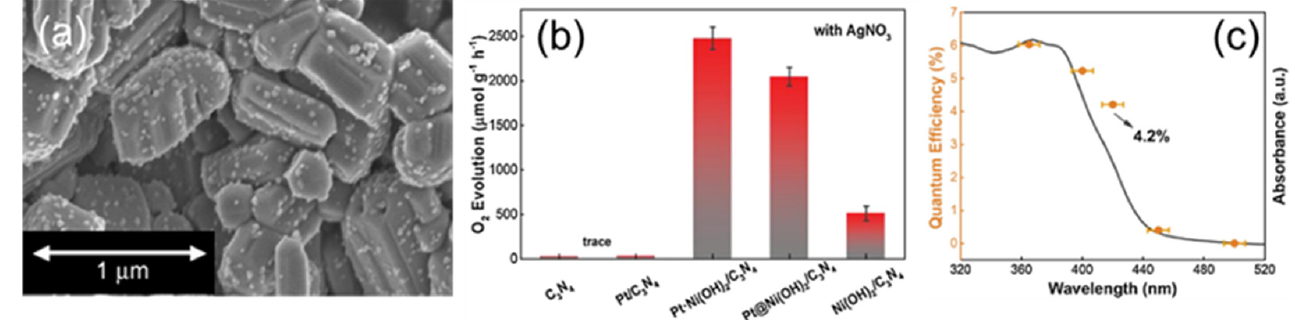
Figure 5. ( a ) SEM image of RuO 2 -loaded β -Ge 3 N 4 . Reproduced with permission from Ref. [51]. Copyright 2005, American Chemistry Society. ( b ) OER rate with AgNO 3 of fabricated photocatalysts. ( c ) Wavelength-dependent AQY (orange dots) of Pt·Ni(OH) 2 /C 3 N 4 . ( b , c ) Reproduced with permission from Ref. [107]. Copyright 2019, Elsevier.